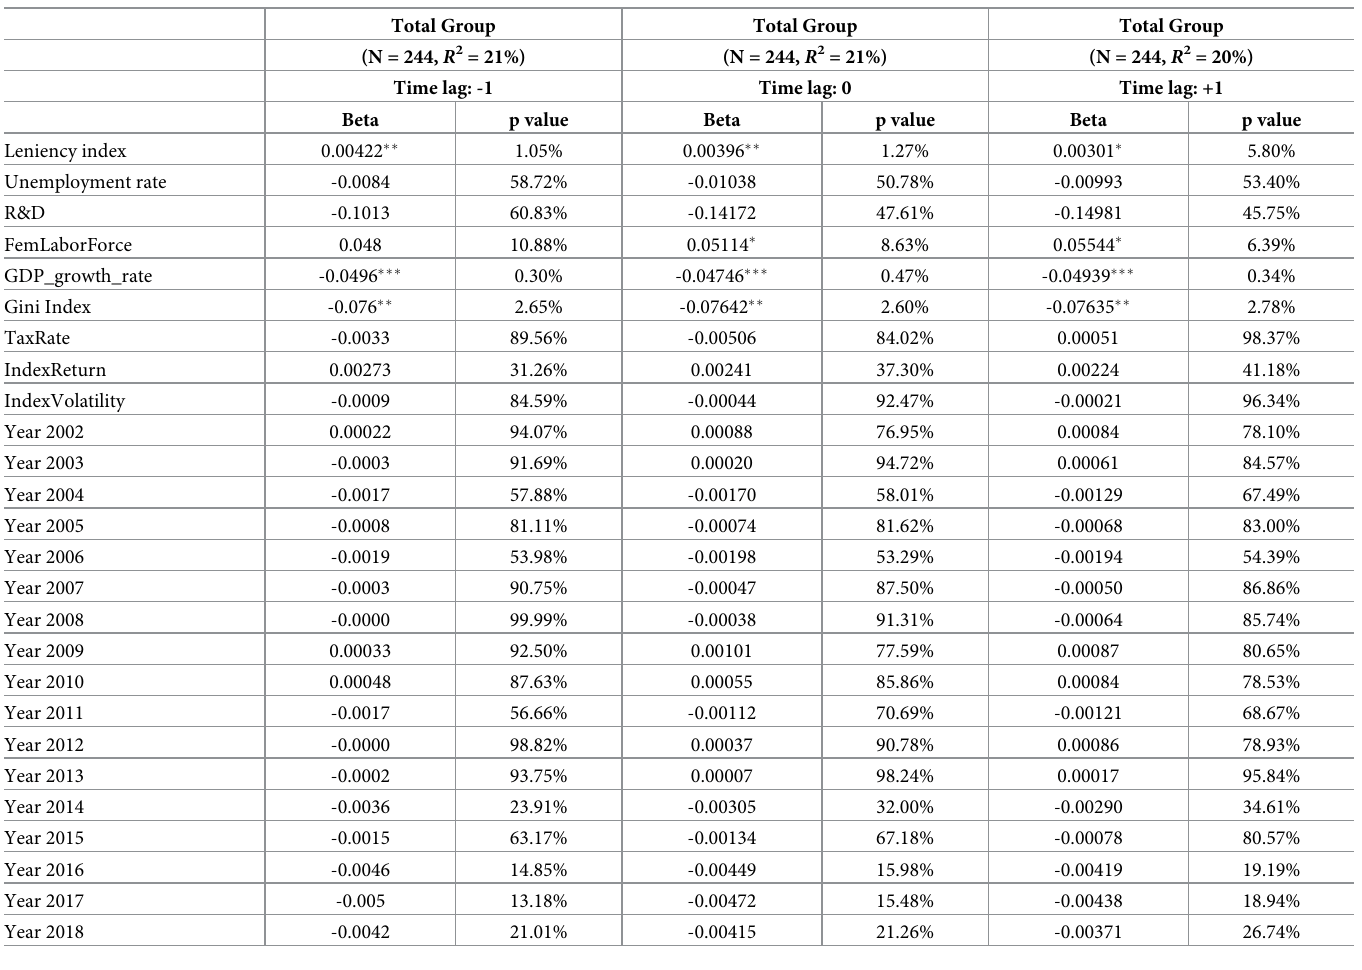
Table 2. The leniency of personal bankruptcy and self-employment: total group with different time